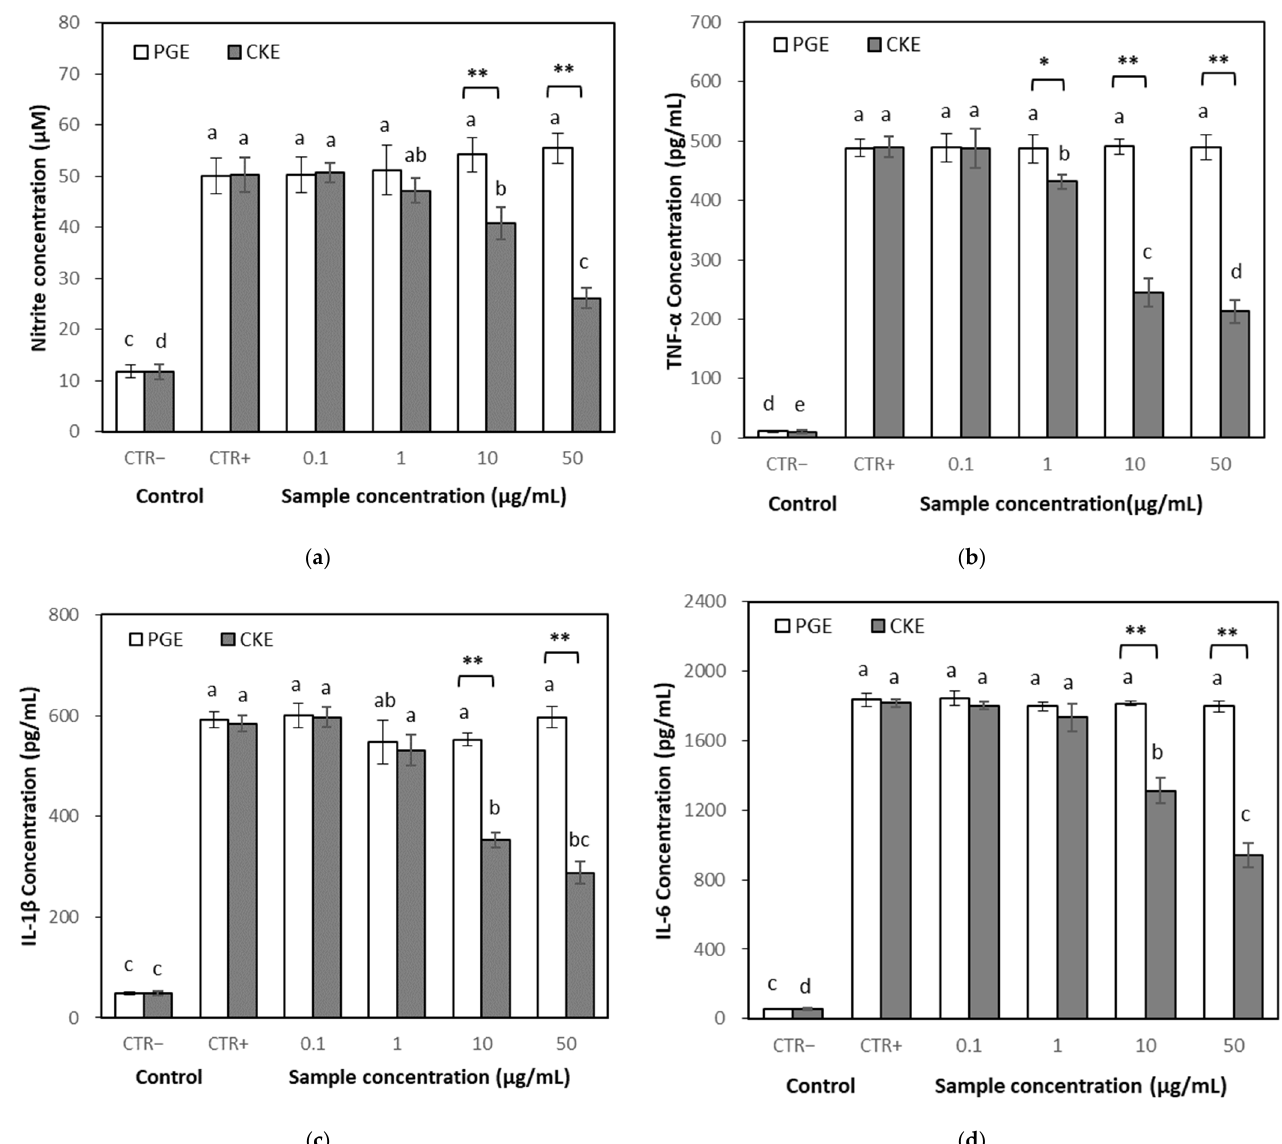
Figure 4. Effect of PGE and CKE extract on the production of nitric oxide (NO), tumor necrosis factor- α (TNF- α ), Interleukine (IL)-1 β and IL-6. RAW 264.7 cells were cultured with different concentrations of PGE or CKE for 24 h with LPS (1 µ g/mL). CTR − , Negative control. CTR+, Positive control (LPS 1 µ g/mL). Result expressed as a mean ± SD ( n = 3). ( a ) Effect on NO; ( b ) Effect on TNF- α ; ( c ) Effect on IL-1 β ; ( d ) Effect on IL-6. Different letters above the bars of the same concentration indicate significant differences among treatment means (*, p < 0.05; **, p < 0.01).